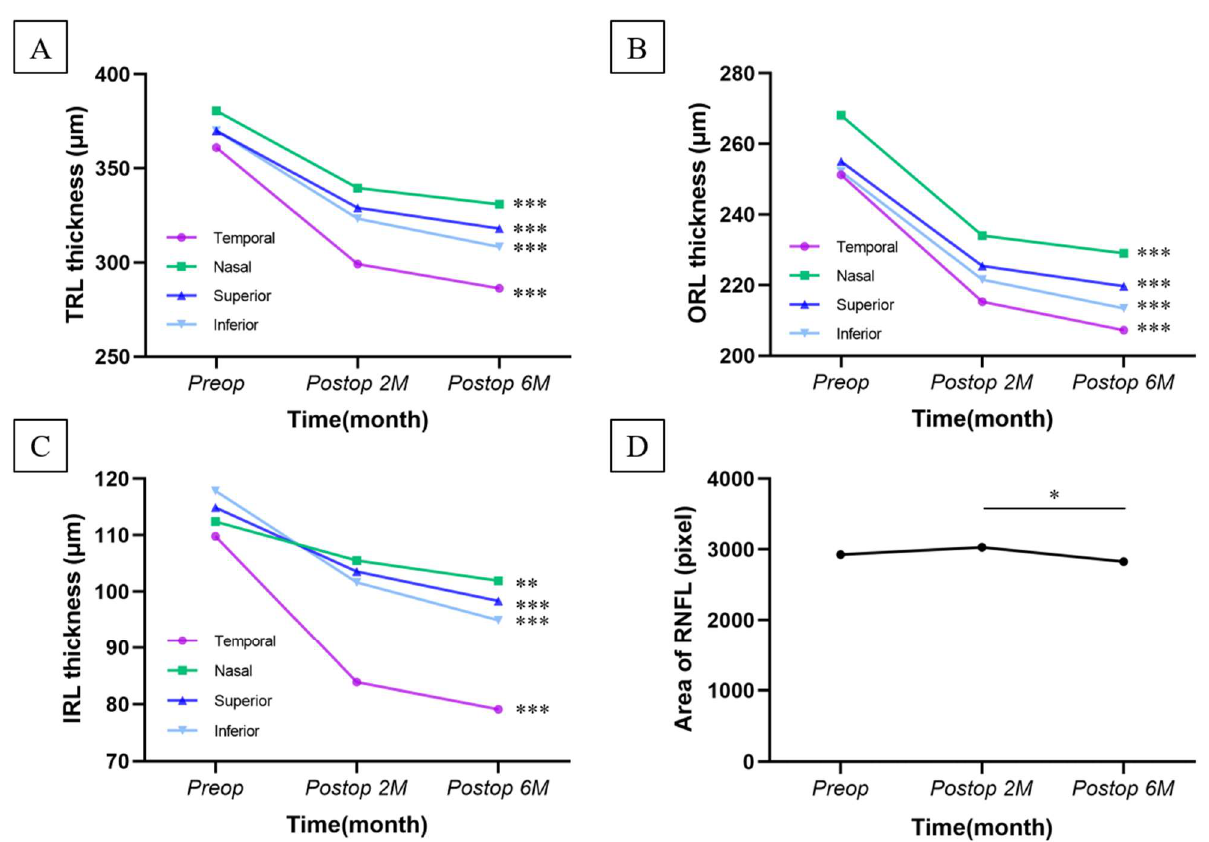
Figure 3. Trends of changes and regional differences in the different retinal layers of the patients with DONFL during postoperative follow-up. ( A – C ). The thickness of TRL, ORL, and IRL decreased significantly in all quadrants. ( D ). The area of RNFL increased slightly at 2-month operatively with no significant difference, then decreased significantly between 2 months operatively and 6 months operatively, but there is still no significant difference compared to the preoperative. * Statistically significant difference( p < 0.05). ** Statistically significant difference( p < 0.01). *** Statistically significant difference( p < 0.001).